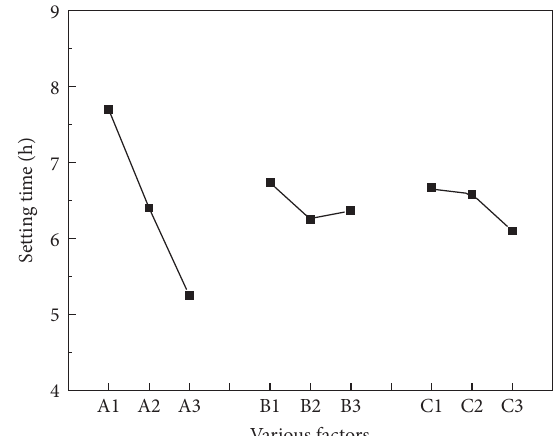
Table 6: Results of the segregation degree ( D 3 ) of paste filling. Figure 4: The tendency of compressive strength and factor level of A B C paste